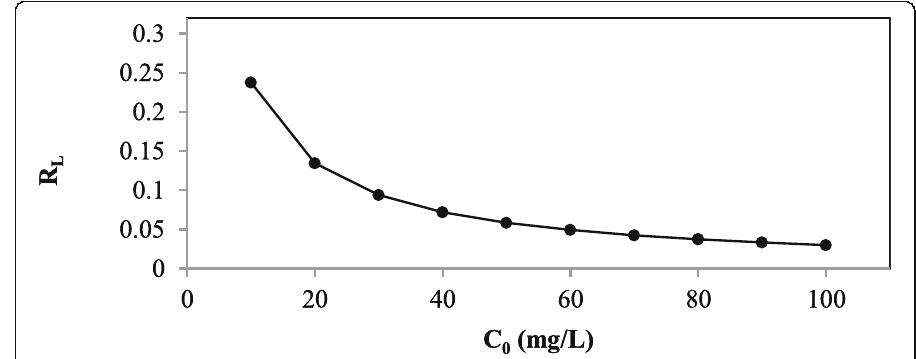
Fig. 14 Evolution of R L ration as a function of initial concentration